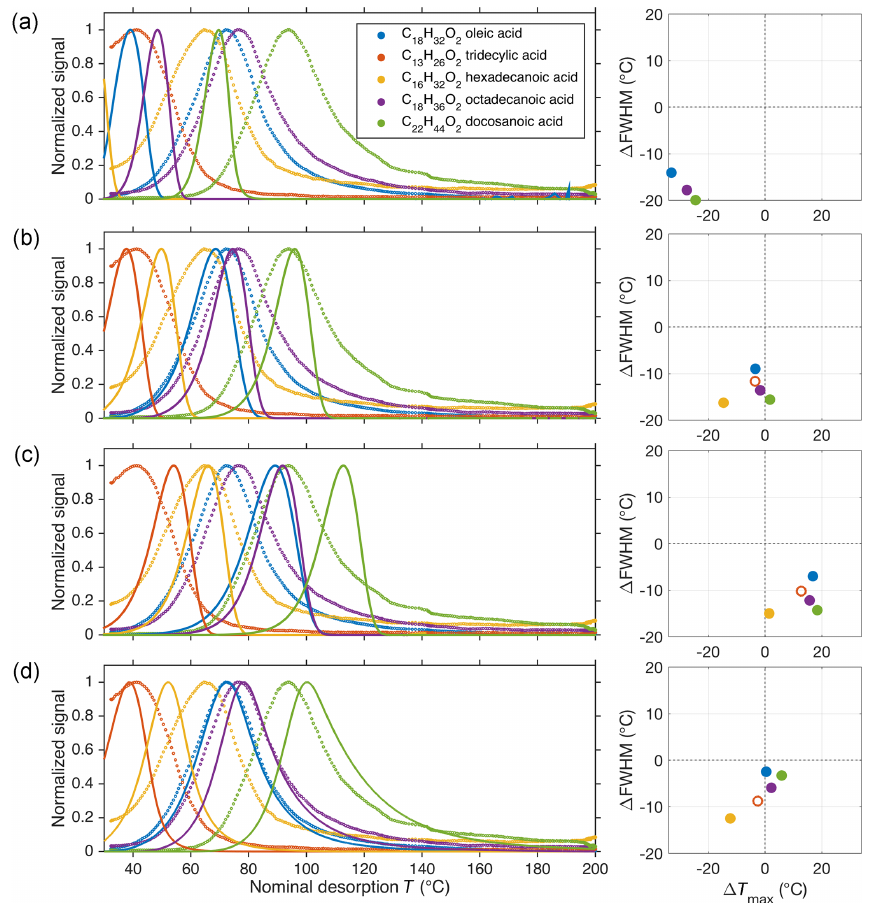
Figure 3. Comparison of experimental results from depositing a solution containing monocarboxylic acids (Lopez-Hilfiker et al., 2014) with four different model results. The left-hand panels show the measured (circles) and modeled (lines) thermograms; the right-hand panels sum- marize differences between model and experiment regarding peak position ( (cid:49)T max = T max , mod − T max , exp ) and full width at half maximum ( (cid:49) FWHM = FWHM mod − FWHM exp ). For (a) , vapor–surface interactions after initial desorption were excluded in the model. For subse- quent panels, these interactions were included as per Eqs. (5) and (6), using a wall parameter τC w of 8.77mgm − 3 s (b) or 149mgm − 3 s (c) . In (d) , the wall parameter was the same as in (b) but assuming uneven desorption temperatures across the deposit, as described in the text and in Fig.